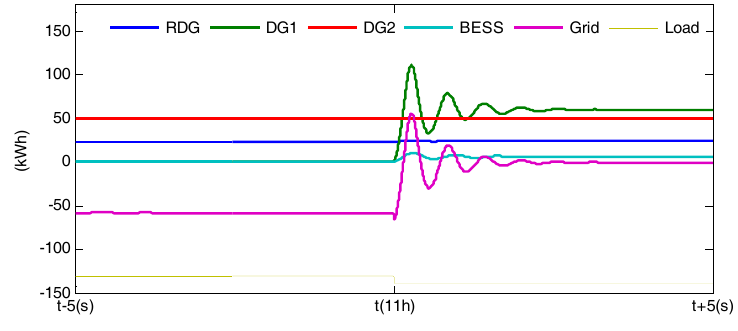
Figure 11. The response of all components in case of reconnecting DG1 at 11 h.